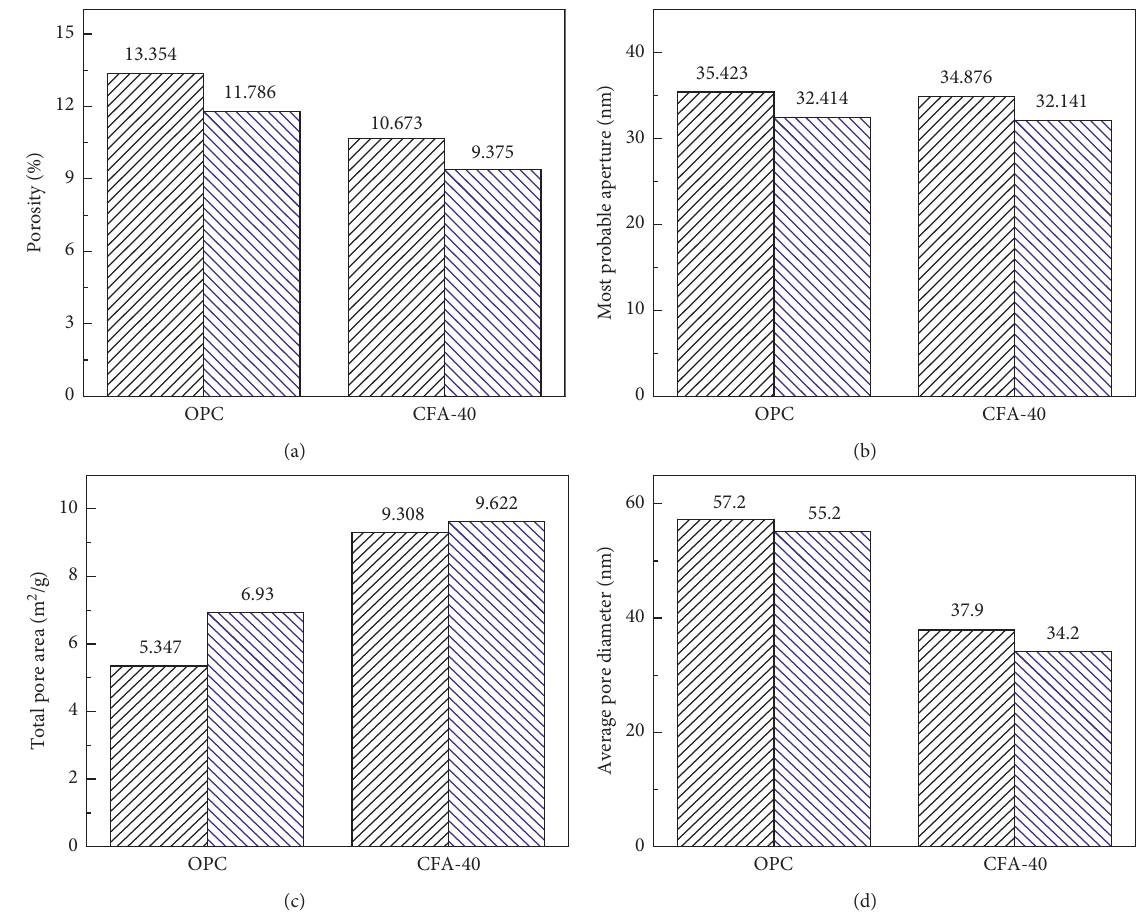
Figure 10: Pore characterization parameters (a) Porosity. (b) Most probable aperture. (c) Total pore area. (d) Average pore diameter.